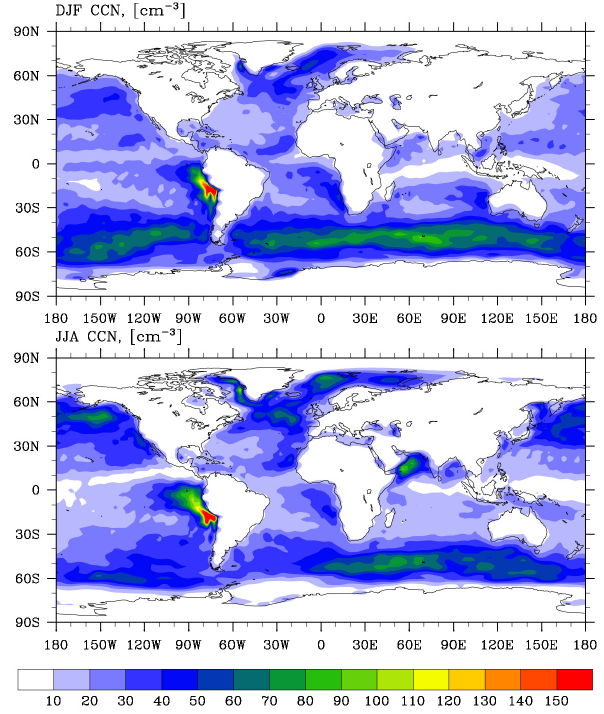
Fig. 22. Modeled global distribution of marine boundary layer CCN at supersaturation of 0.1% in the boreal winter (DJF, December, January, and February) and summer (JJA, June, July, and August) of 2006. The model used the CMS source function and a solubility factor of